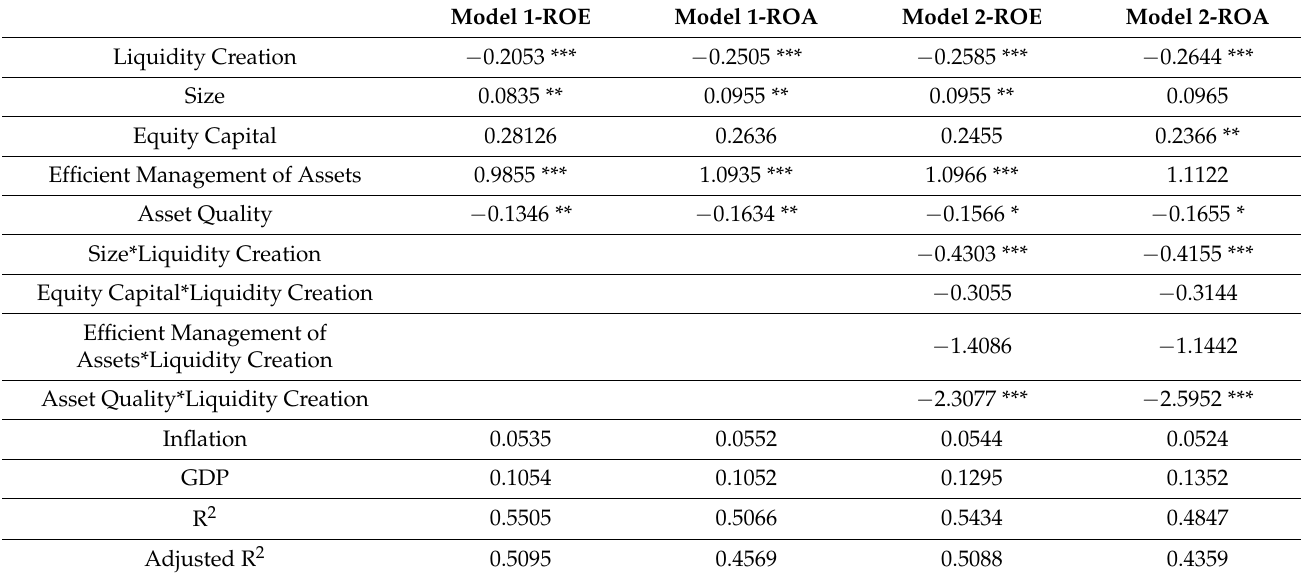
Table 4. Two-Stage least squares